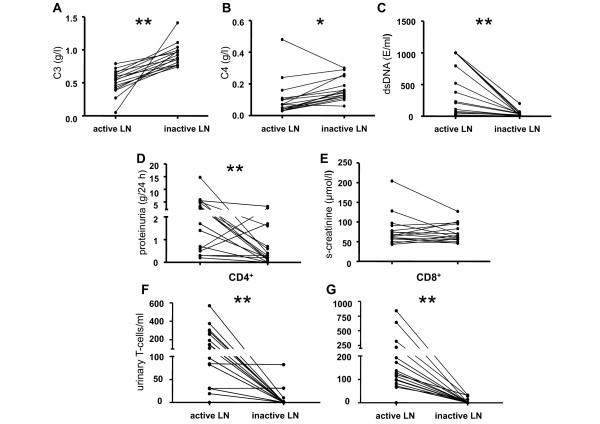
Laboratory data of serially analyzed LN patients (n = 16) during active and inactive LN. Intra-individual comparison between levels of C3, C4, anti-dsDNA titres, proteinuria, s-creatinine, urinary CD4+ and CD8+ T-cell counts in lupus nephritis (LN) patients (n = 16) during active and inactive LN is shown in sections A-G. The time interval between these two assessments was 14 ± 4 months. P-values were calculated using the nonparametric Wilcoxon signed rank test. Significant differences are indicated (P <0.05 = *, P <0.005 = **).